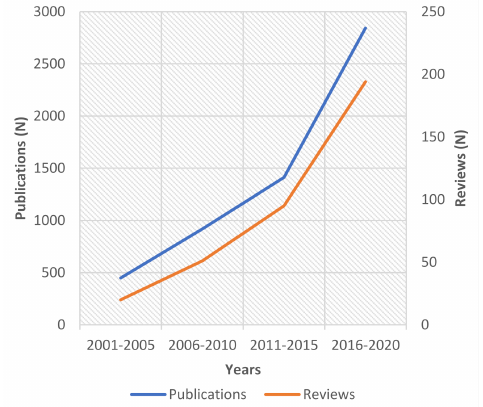
Figure 1. Publication and review grow, CS1, SCOPUS search